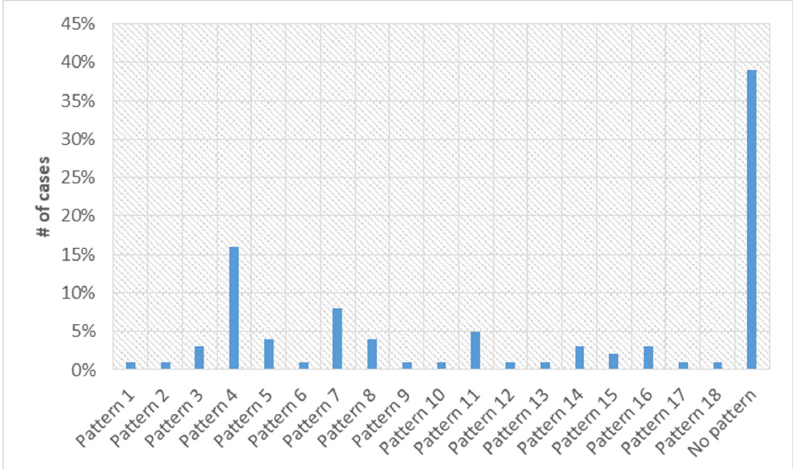
Figure 7. Number of cases for each of the 18 patterns of multidrug resistance for the 152 nosocomial patients (from the database described in Section 2.2).